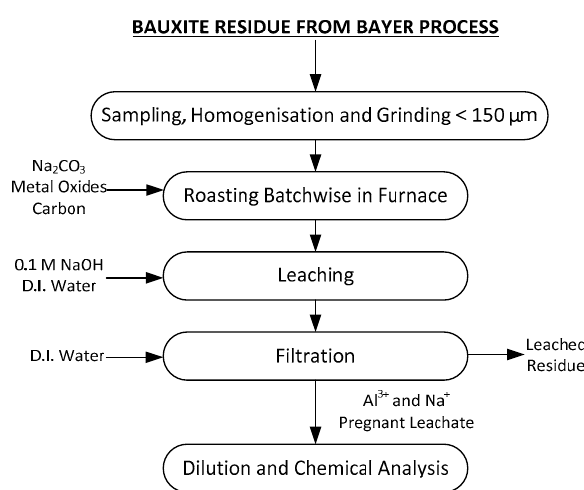
Figure 4. Procedure for sintering of AoG’s Greek bauxite residue.